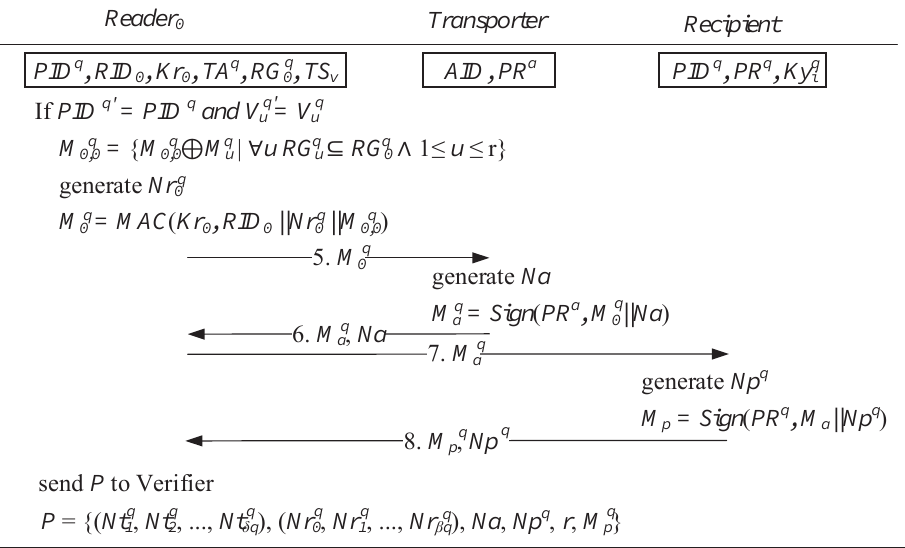
Figure 4. Affirming tags and proofs signed by both sides and verifying time